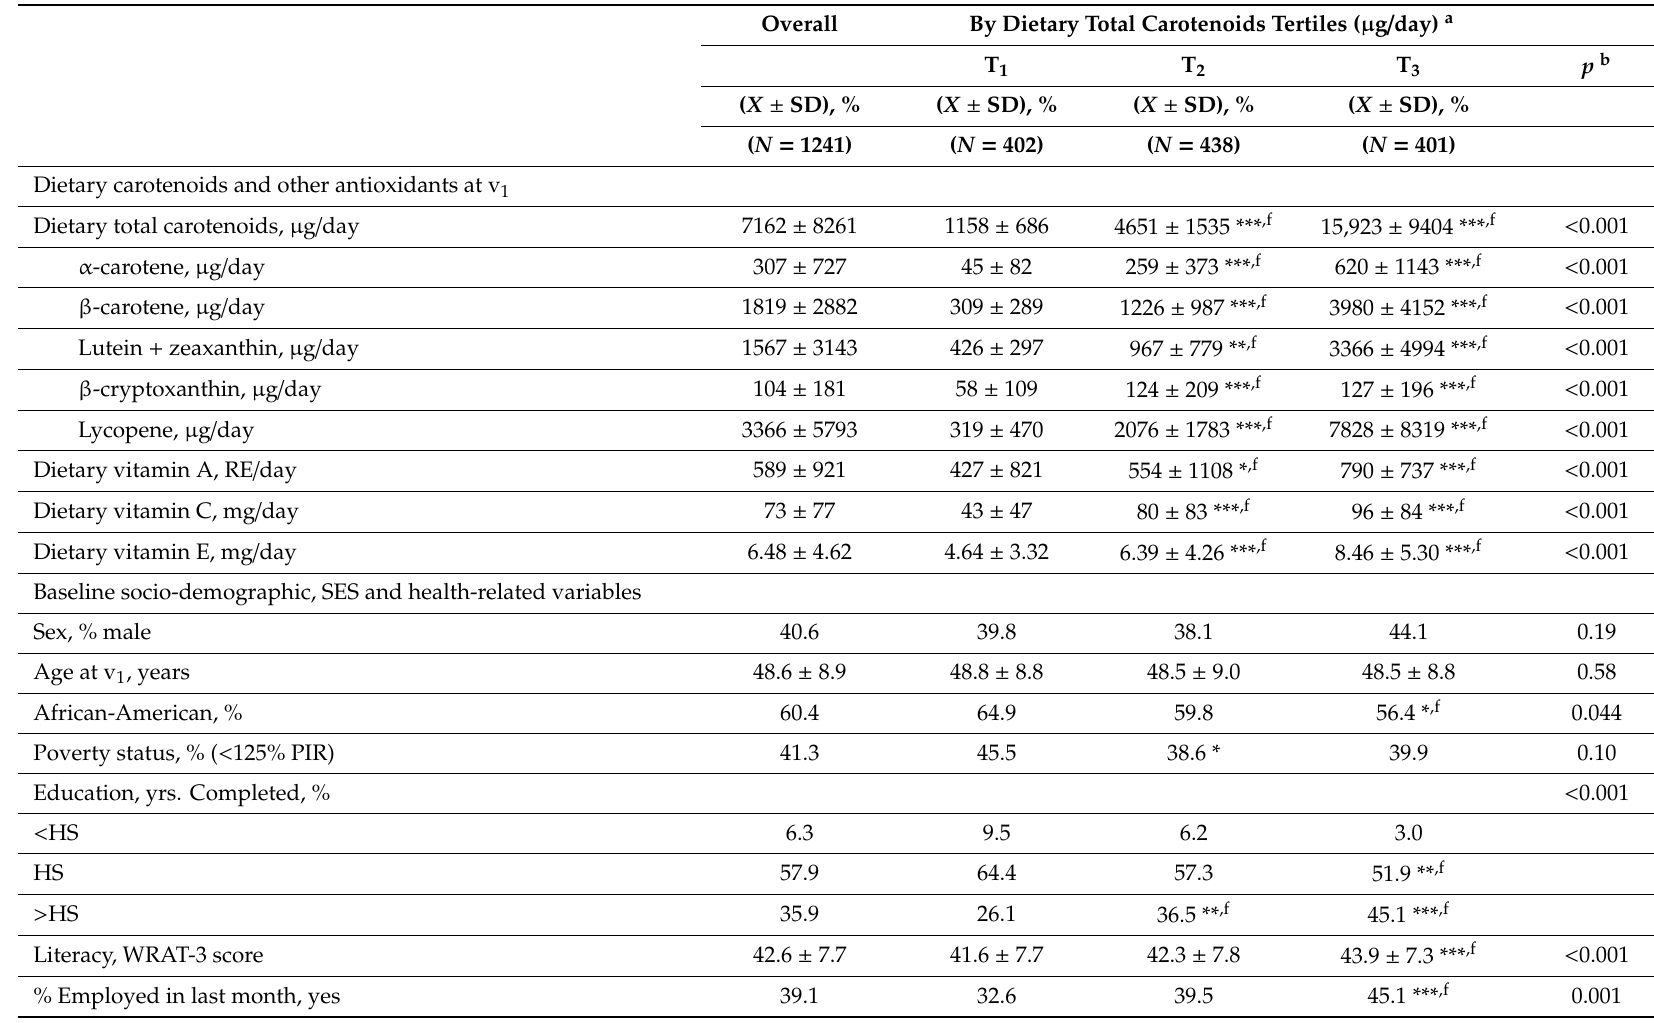
Table 1. Study sample characteristics by tertile of dietary total carotenoids for sub-sample with complete and valid MMSE data, HANDLS 2004–2013 a . Overall By Dietary Total Carotenoids Tertiles ( µ g / day)